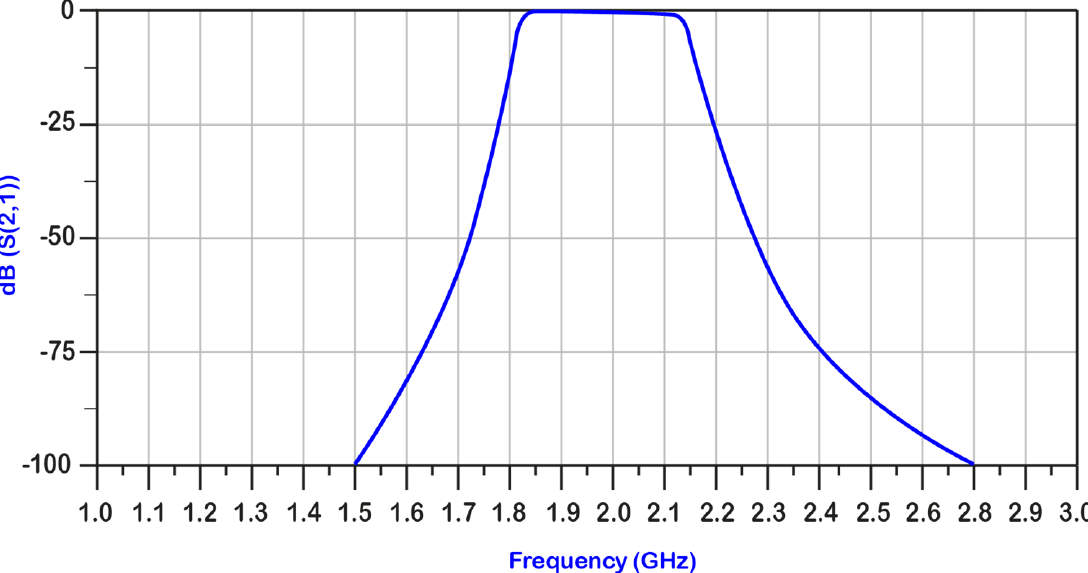
Figure 2. Simulation results of the transmission coefficient, S 21 , vs. frequency, of YBCO filter.